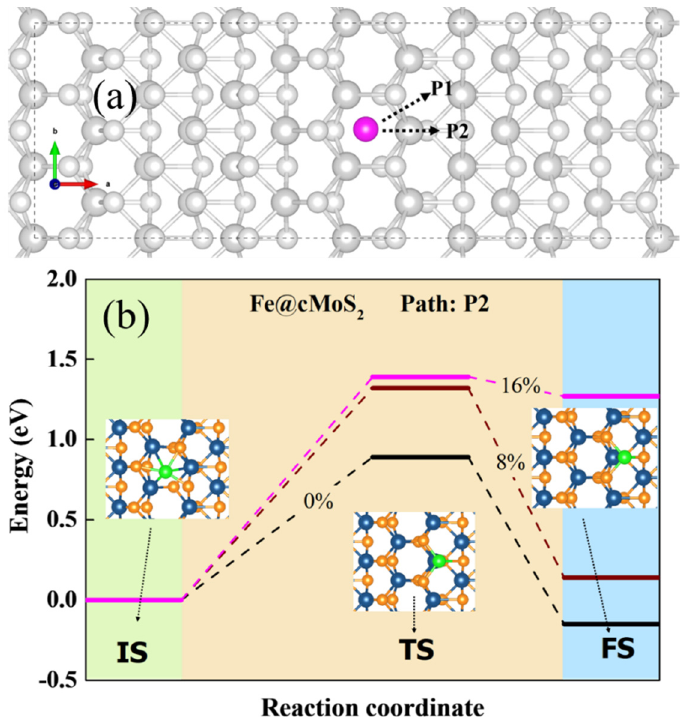
Figure 4. ( a ) The possible pathway of M diffusion in cMoS 2 . ( b ) The diffusion coordinates of the Fe atom in cMoS 2 at different compressions. The inset is the corresponding top view of different states.